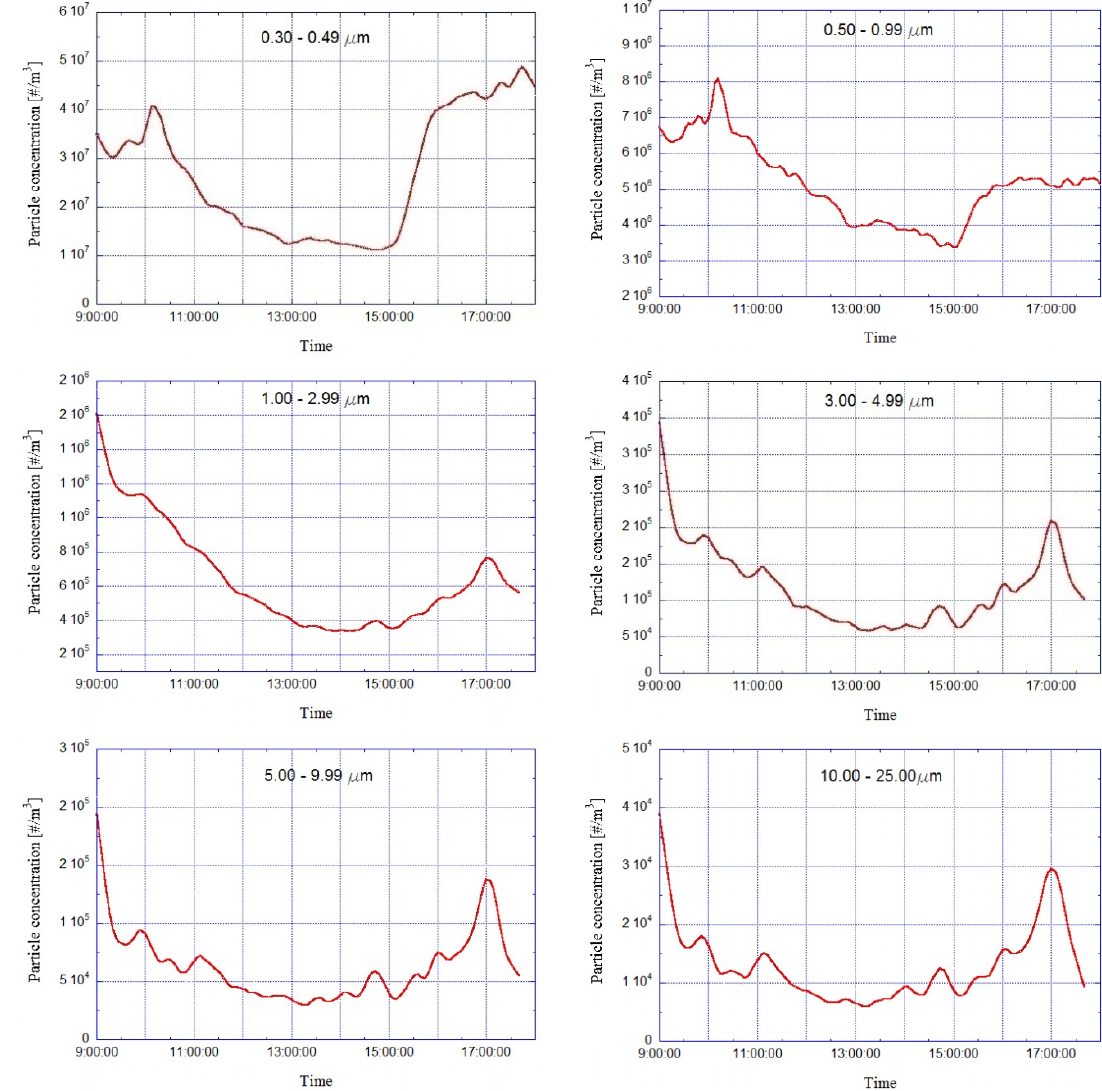
Figure 8. Hourly trend (9 a.m.–6 p.m.) of the PM mean number concentration monitored in Strinella Street, L’Aquila, over the period January 2016–April 2016 for each of the six granulometric channels investigated. Analysis of hourly averages. Data collected by OPC TSI .